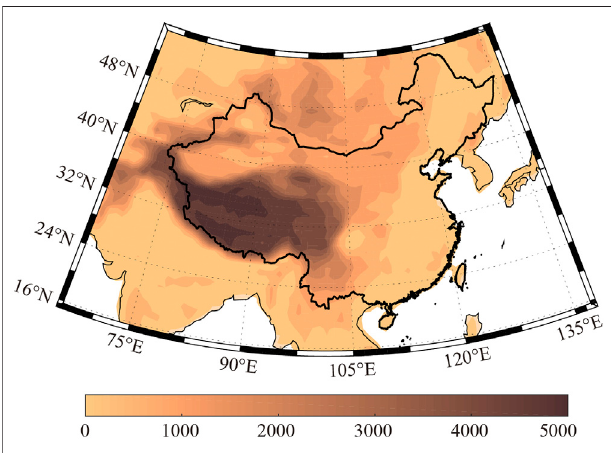
FIGURE 1 | Model domain and terrain height (unit: